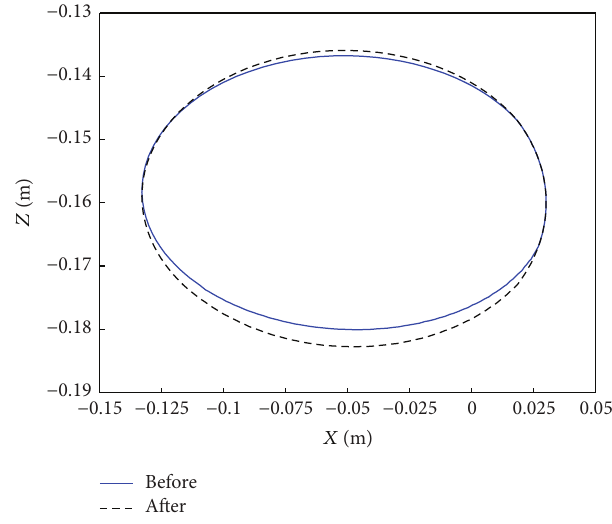
Figure 6: Ellipse trajectory of galloping.